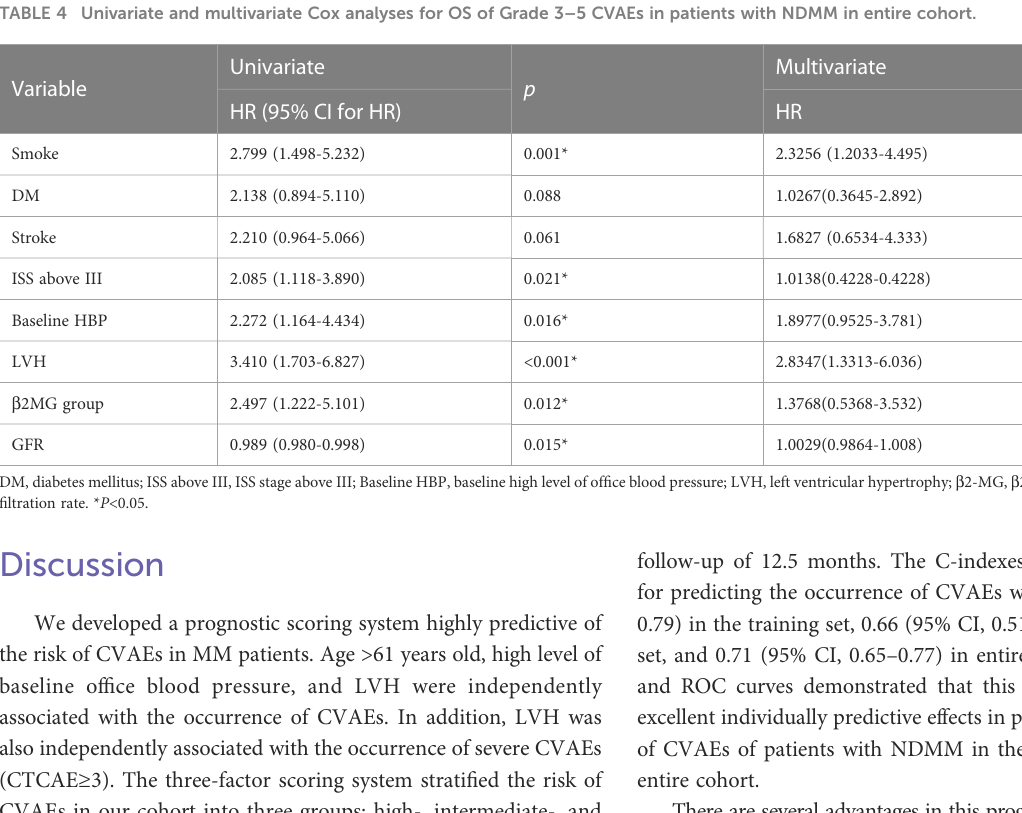
TABLE 4 Univariate and multivariate Cox analyses for OS of Grade 3 – 5 CVAEs in patients with NDMM in entire cohort.